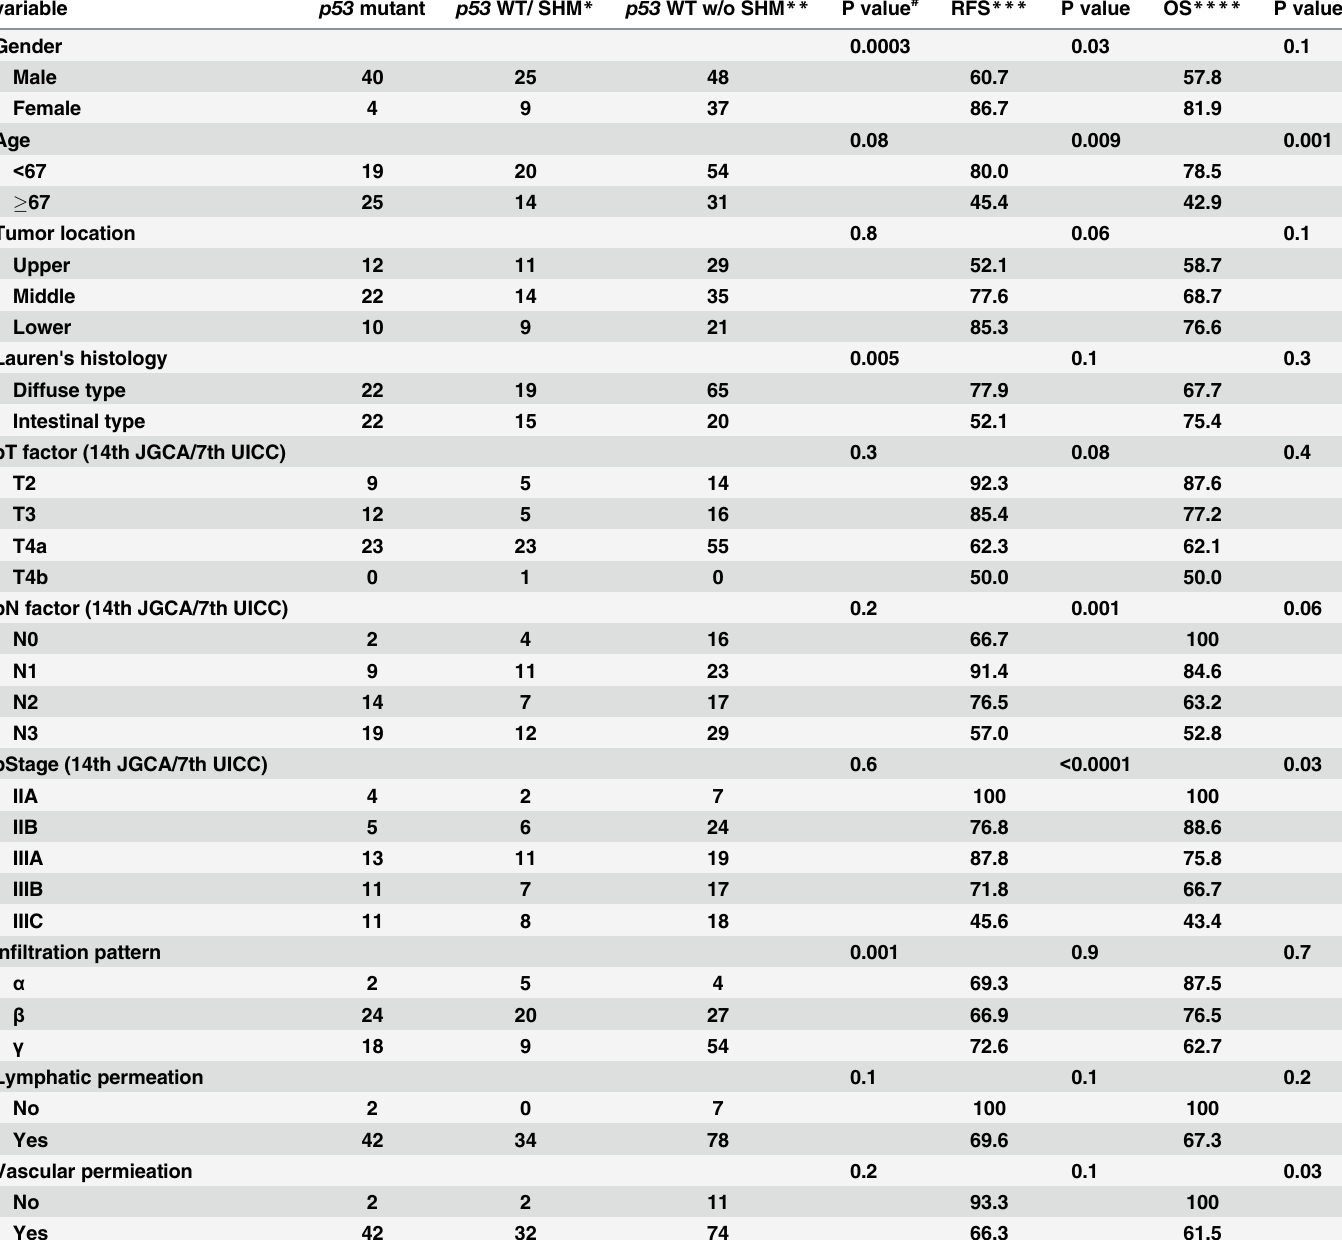
Table 1. Distribution of clinical and pathological factors for correlation with gene & methylation status and univariable prognostic analysis in 163 pStageII/III gastric cancer with gastrectomy and subsequent S-1